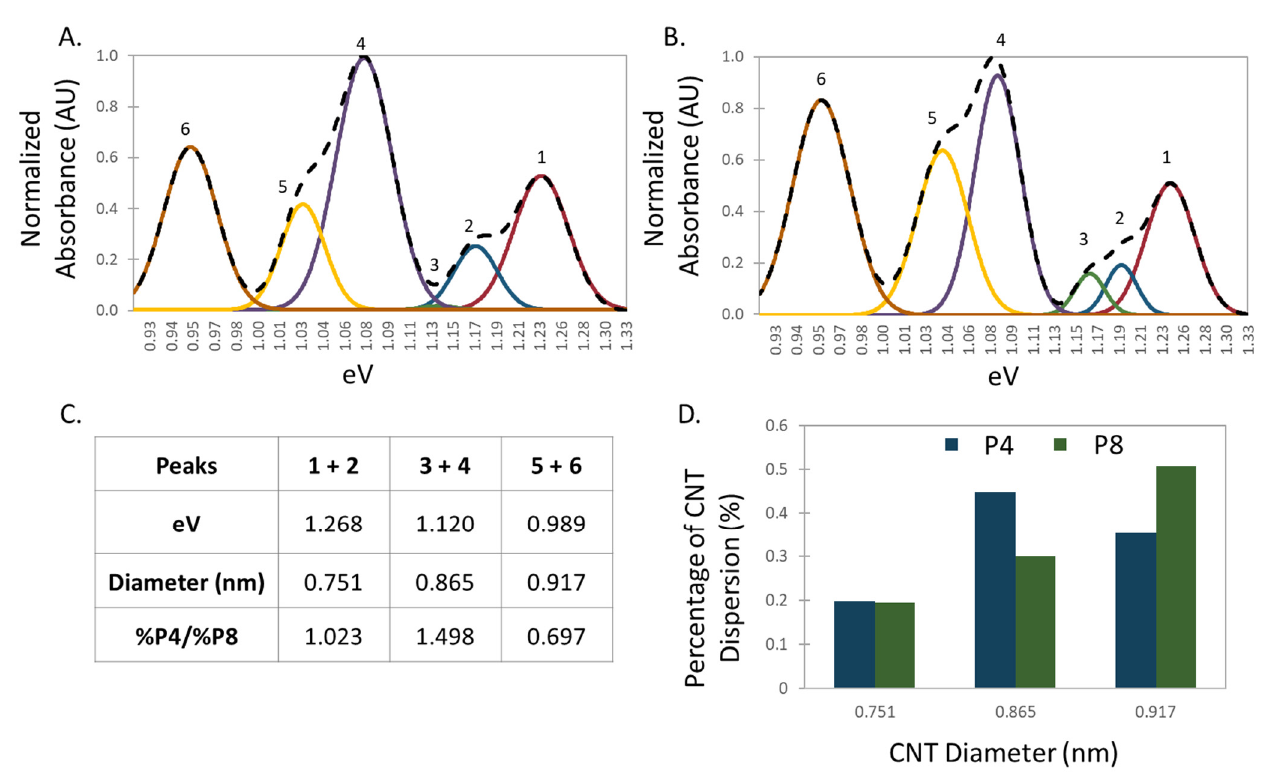
Figure 3. Deconvoluted spectra of ( A ) CoMoCAT dispersion with binding peptide, P4, and ( B ) HiPCO dispersion with P8 peptide, dispersing HiPCO CNTs. All absorbance data are presented in the semiconducting S11 range. ( C ) Peaks were separated by small (0.751 nm), medium (0.865 nm), and large (0.917 nm) SWNT diameter to ( D ) compare diameter dependent dispersion for CoMoCAT and HiPCO identified binding peptides.